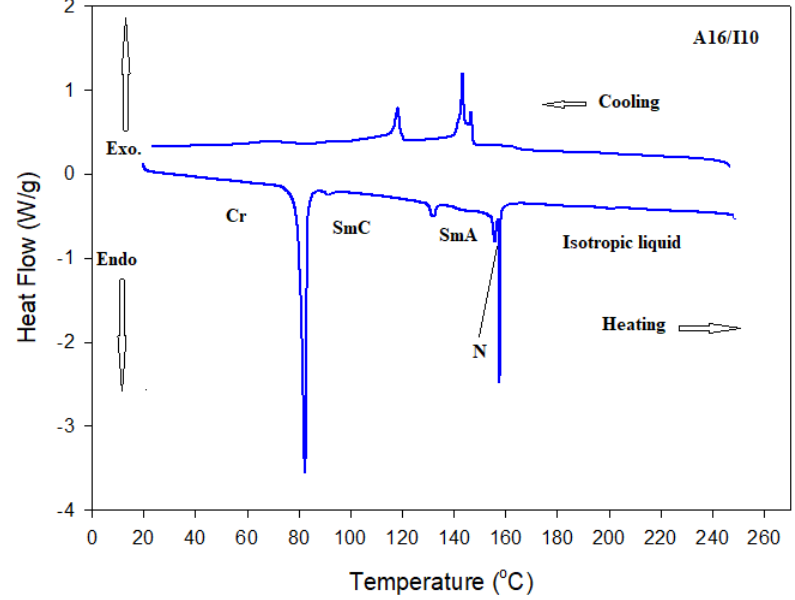
Figure 3. Polarizing optical microscopy (POM) textures upon heating of SMHBC A16 / I10 ( a ) SmC phase at 120.0 ◦ C; ( b ) SmA phase at 143.0 ◦ C; and ( c ) nematic phase at 157.0 ◦ C.